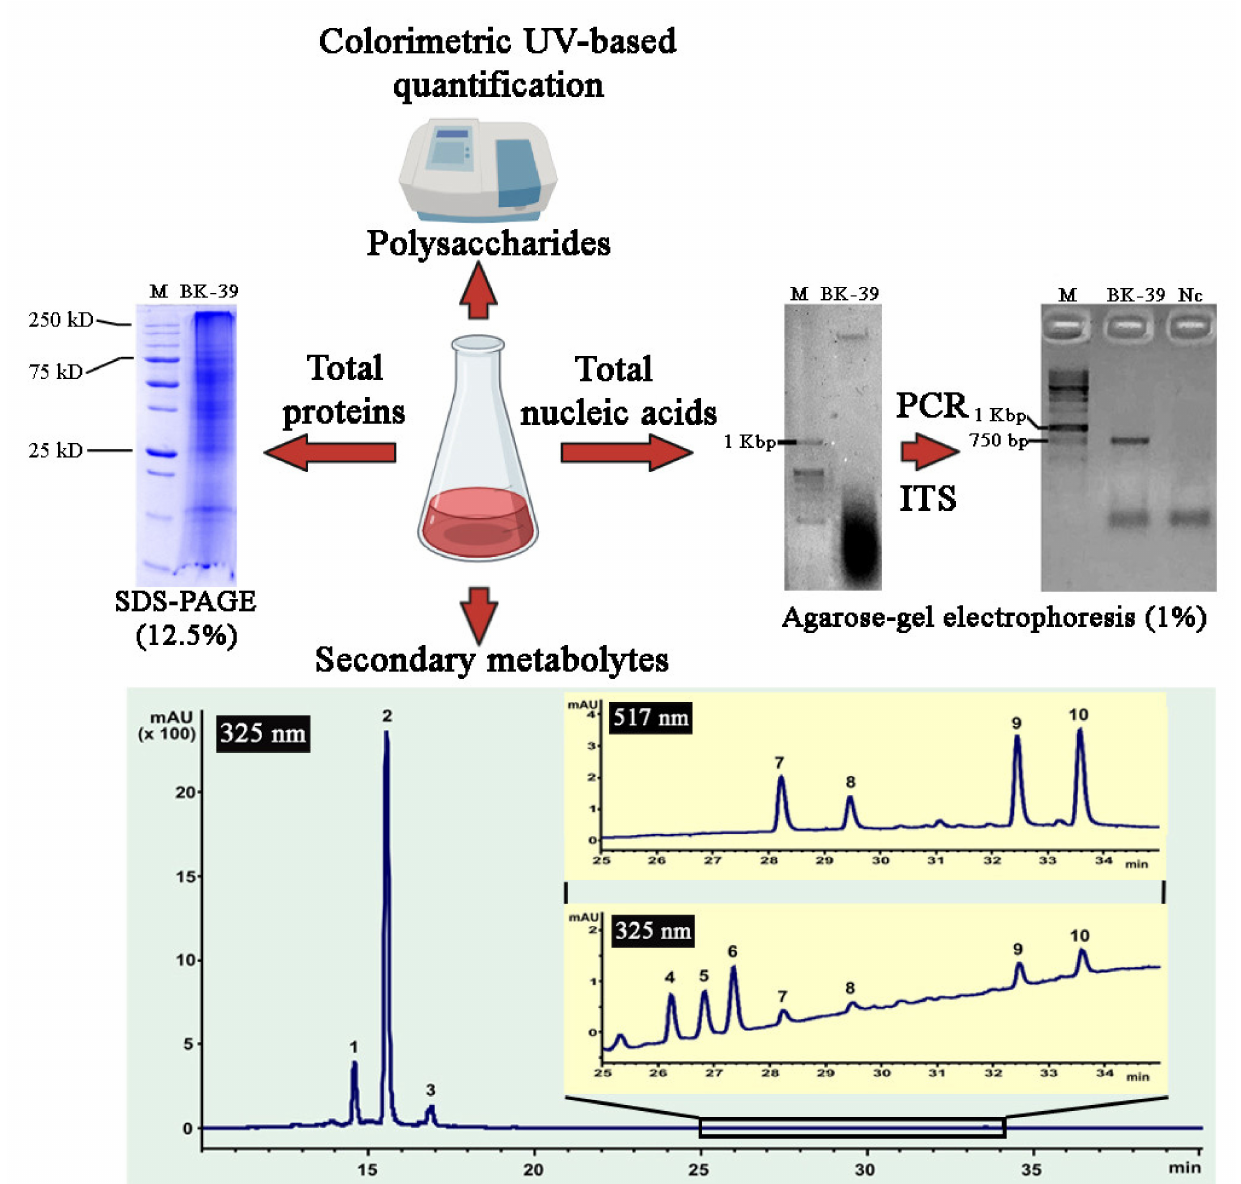
Figure 10. Analysis of nucleic acids, proteins, polysaccharides, and secondary metabolites presented in L . erythrorhizon callus